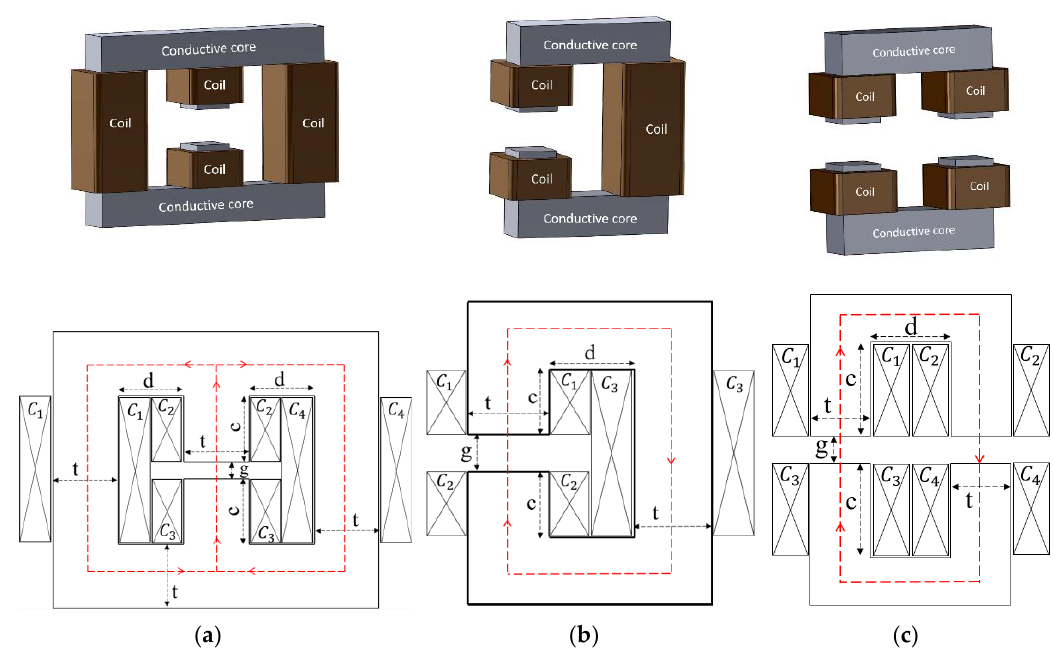
Figure 2. Three electromagnet designs considered for the proposed adaptive tuned vibration absorber (ATVA). ( a ) H-shaped electromagnet; ( b ) C-shaped electromagnet; and ( c ) U-shaped electromagnet.